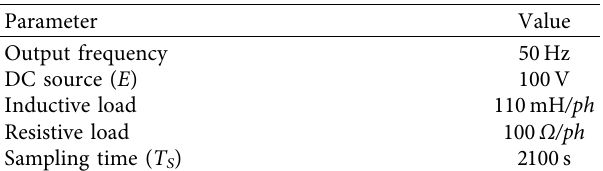
Table 7: Simulation